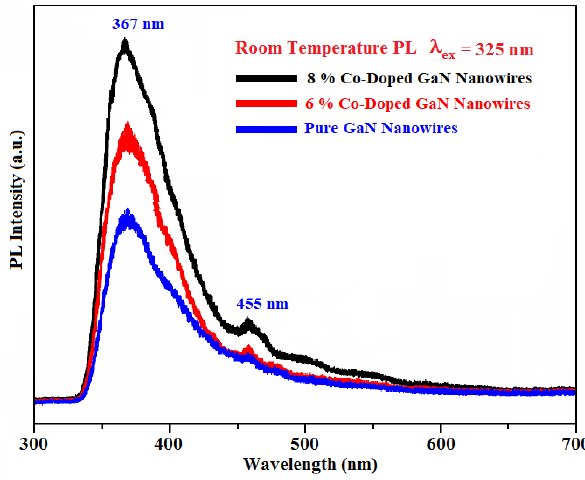
Figure 7. Photoluminescence of pure and cobalt doped (6% and 8%) GaN nanowires.